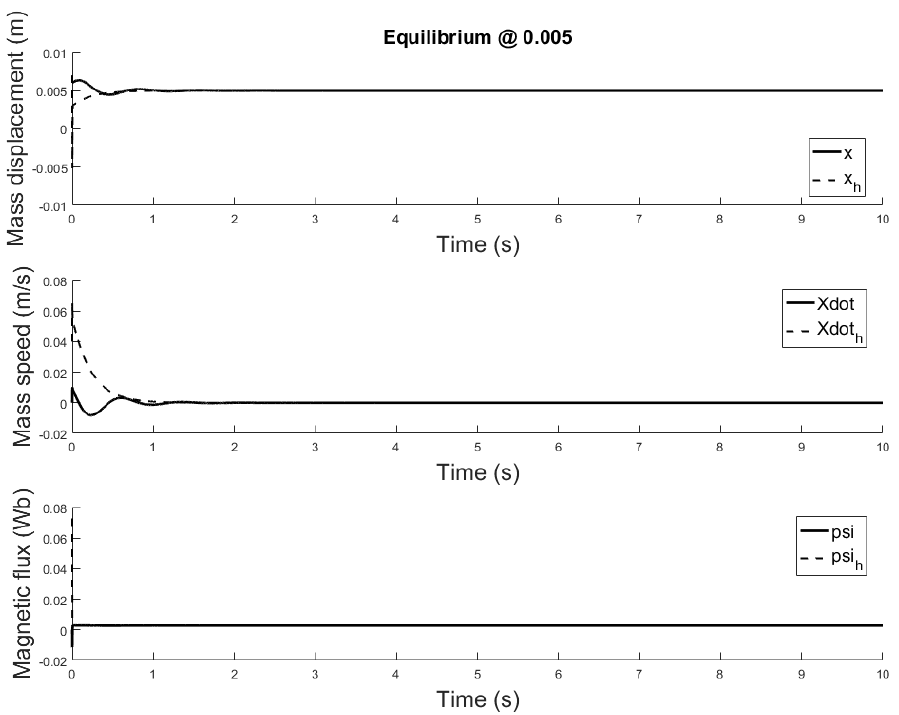
Figure 17. Observer and plant state estimates for initial conditions: x 0 = 0.006 m, ˆ x 0 = 0.001 m and . x 0 = 0 m/s, ˆ x 0 = 0.04 m/s and ψ = 0 Wb, ˆ ψ = 0.07 Wb, equilibrium at x = 0.005.